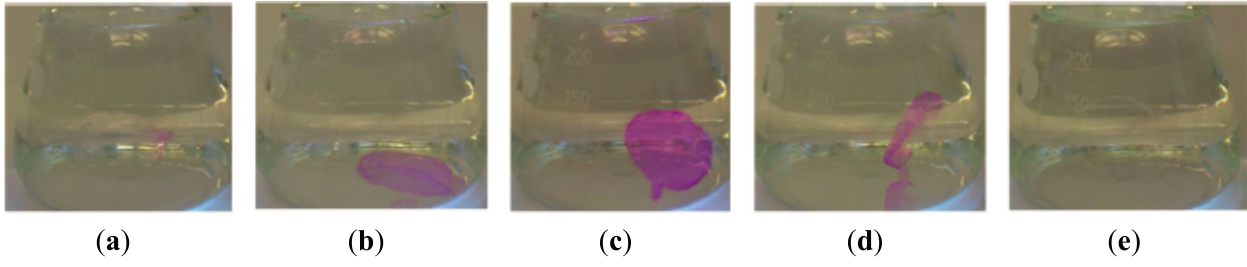
Figure 11. Cross-linked phenolphthalein containing polymer blank in distilled water ( a ), after adding NaOH solution ( b ), over pH 10 ( c ), after adding HCl ( d ) and again in neutral solution ( e ) [57]. Reprinted with the permission from Macromolecules, 2012, 45 , 5343–5346. Copyright 2012 American Chemical